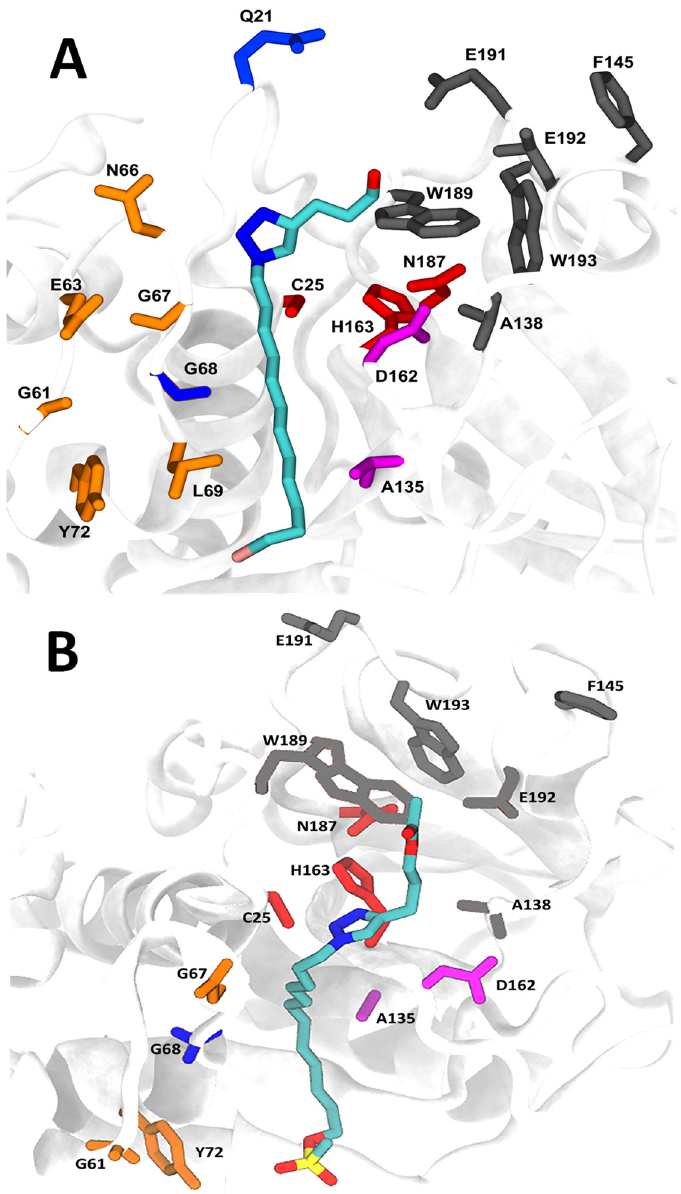
Figure 9. Molecular docking of cathepsin L with compounds C9 and C21 . ( A ) Cathepsin L ‐ C9 complex. ( B ) Cathepsin L ‐ C21 complex. Catalytic triad in red (Cys25, His163; Asn187). Amino acid subsites: S’3 in deep purple (A135; D162), S’2 in black (W189, A138, E192, W193, F145; E191), S1 in blue (G68, Q21), S2 in magenta; S3 (N66, E63, G67, G61, L69; Y72) in orange.